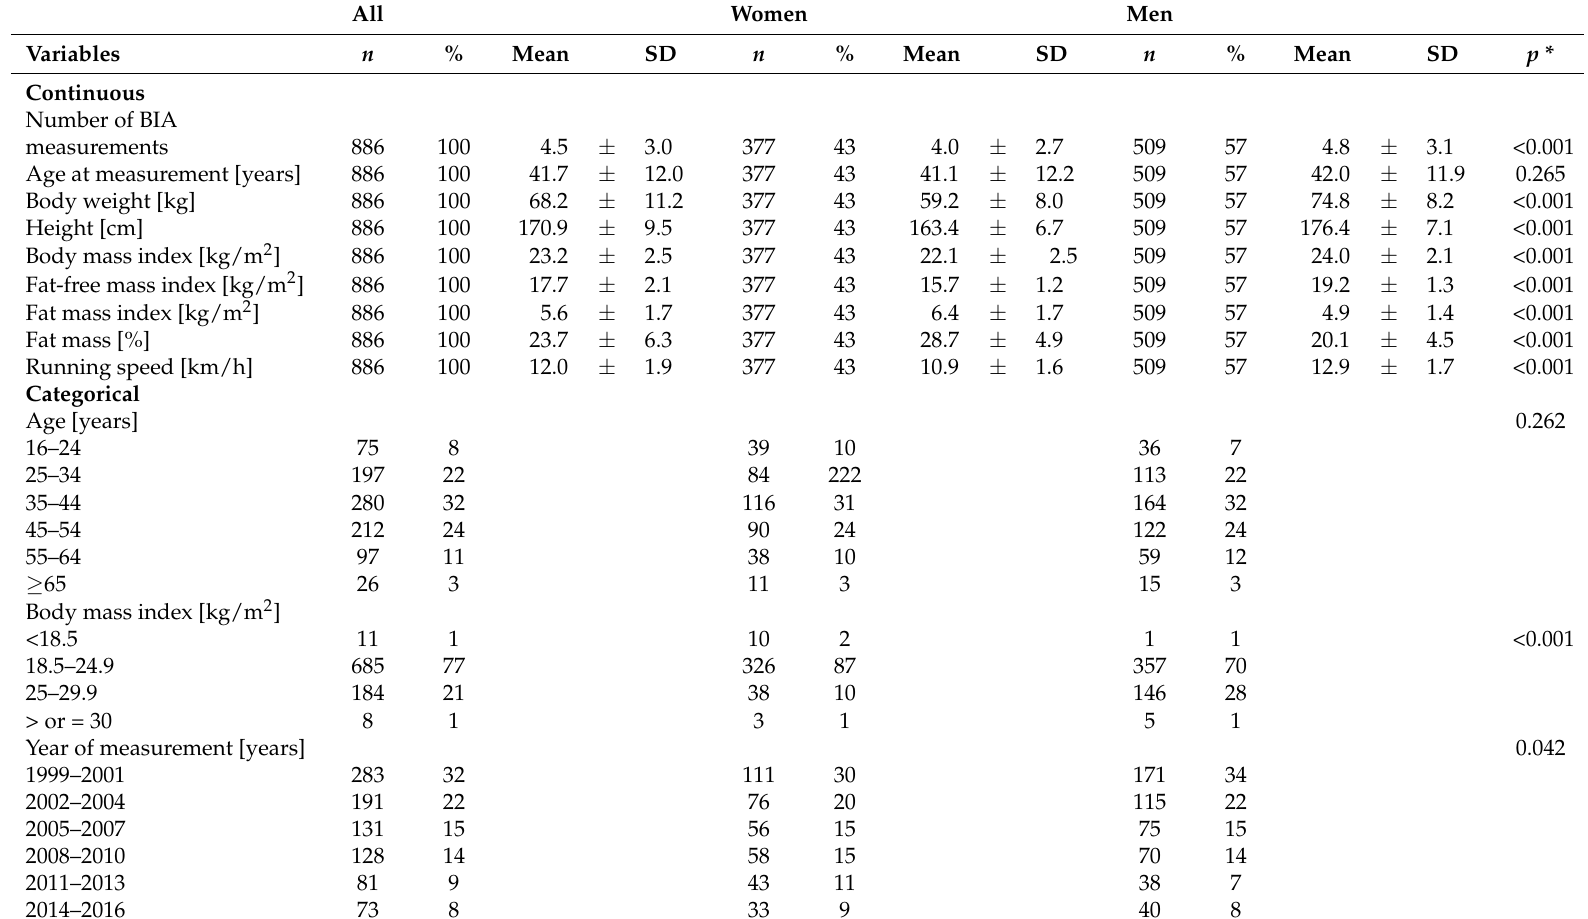
Table 1. Characteristics of the study population at baseline ( n =